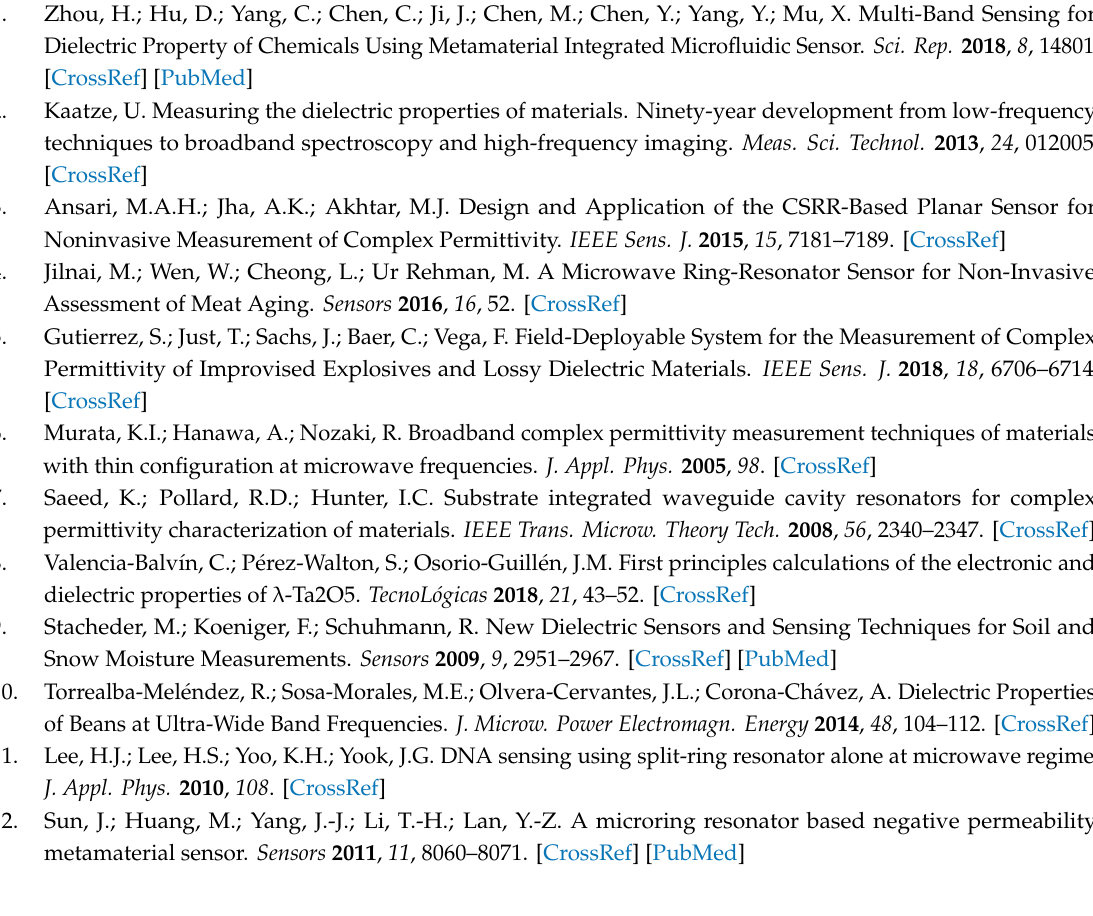
Figure S1: Experimental results obtained with the Agilent 85070E Dielectric Probe Kit for ( a ) acetone at 96% purity. ( b ) Propyl alcohol at 92% purity. ( c ) Methanol at 92% purity. ( d ) Ethylene glycol at 93%